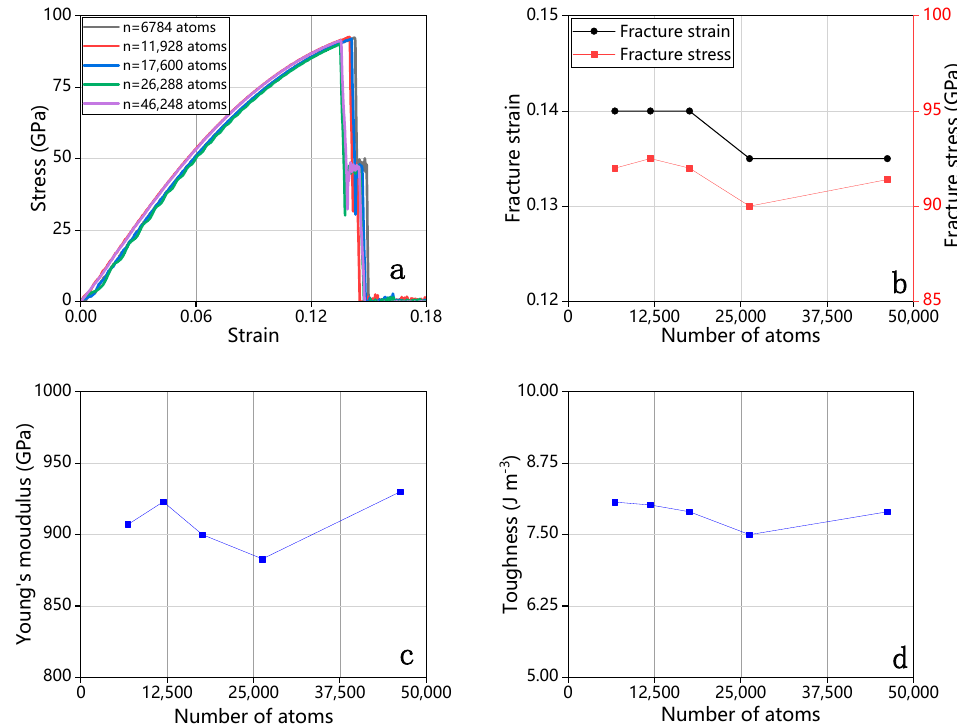
Figure 2. The effect of increasing the number of atoms on the mechanical properties of bilayer graphene. ( a ) Stress–strain relationships, ( b ) Fracture stress and Fracture strain, ( c ) Young’s modulus, ( d ) Toughness. As the variation in the number of atoms has a limited impact on the mechanical properties of bilayer graphene, we selected 11,928 atoms in this study.